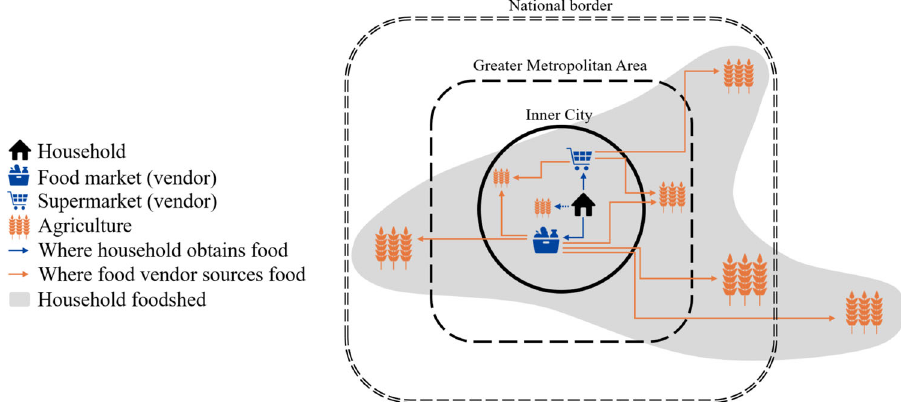
Fig. 1 Schematic representation of the foodshed of an urban household. The household indicates where their food supply is obtained. The vendors indicated by the household indicate the agricultural locations where their food supply is sourced (generally via suppliers). Households and vendors may also source food directly from the farm. The area encompassing this entire system is the household ’ s